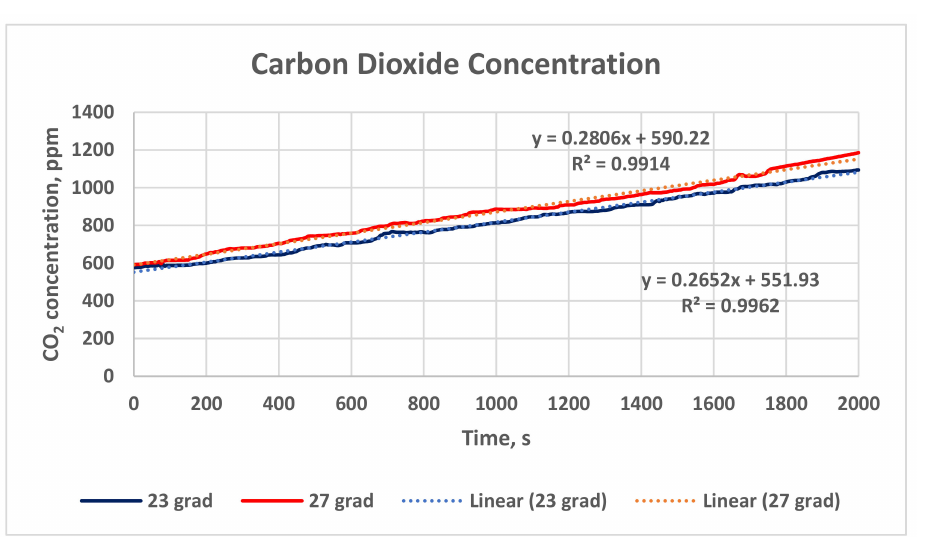
Figure 12. Carbon dioxide concentration in the classroom during Stage 1 (27 ◦ C) and Stage 2 (23 ◦ C). Based on Student’s t -test, the statistical analysis shows a proven difference between the CO 2 concentration in Stage 1 and Stage 2 (the red and blue lines in Figure 12). The statistical value (absolute value) of the t -test is higher than the critical value ( t stat = 4.79, t crit = 1.96 ( α = 0.05)), which proves the hypothesis that the indoor air temperature influenced the accumulation of the CO 2 in the classroom.